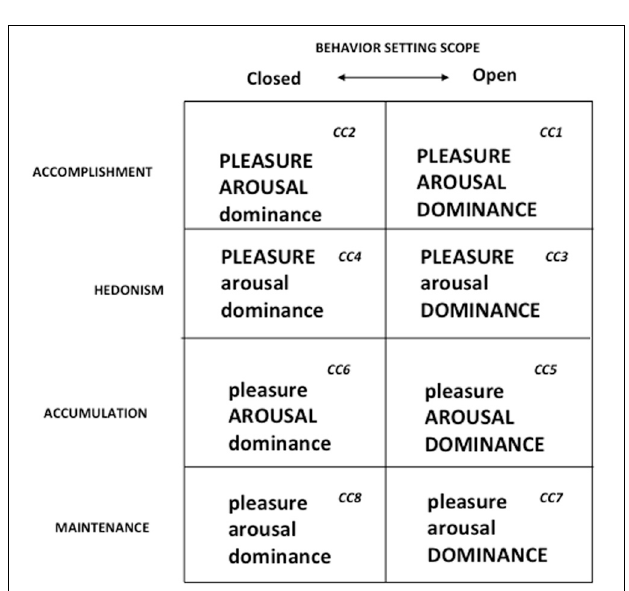
FIGURE 6 | The BPM emotion-contingency matrix. Source : Foxall (2011). Used by permission. The figure summarizes the research hypotheses and findings. Studies show that: (i) pleasure scores for contingency categories (CCs) 1, 2, 3, and 4 each exceed those of CCs 5, 6, 7, and 8; (ii) arousal scores for CCs 1, 2, 5, and 6 each exceed those of CCs 3, 4, 7, and 8; (iii) dominance scores for CCs 1, 3, 5, and 7 each exceed those for CCs 2, 4, 6, and 8. Moreover, (iv) approach–avoidance (aminusa) scores for CCs 1, 2, 3, and 4 each exceed those for CCs 5, 6, 7, and 8; and (v) approach–avoidance scores for CCs 1 and 3 each exceed those for CCs 2, 4, 5, 6, 7, and 8. (For explication, see text and Foxall et al.,